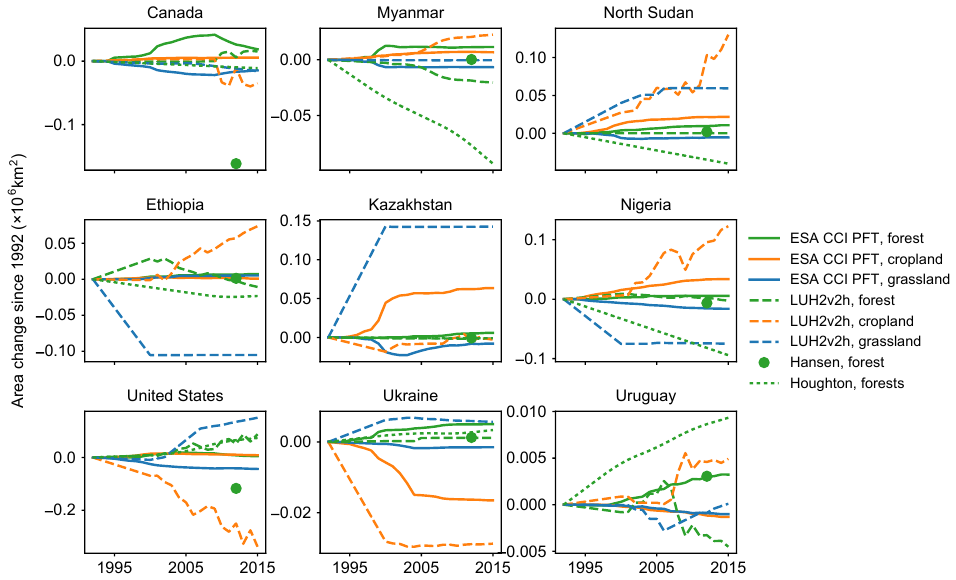
Figure 6. Net area changes in forest, cropland and grassland PFTs derived from ESA CCI land cover maps since 1992 in countries with largest net forest area gain between 1992 and 2015. Data from LUH2v2h (Hurtt et al., 2011), Hansen et al. (2013) and Houghton and Nassikas (2017) are also shown for